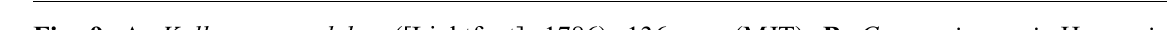
Fig. 9. A . Kalloconus pulcher ([Lightfoot], 1786), 136 mm (MJT). B . Conus siamensis Hwass in Bruguière, 1792, lectotype, 102 mm (MHNG-MOLL-52702). C . Kalloconus marimaris Tenorio, Abalde & Zardoya, 2018, holotype, 38.6 mm (MNCN 15.05/79664). D . Kalloconus marimaris , paratype, 36.6 mm (MNCN 15.05/79689). E . Conus pseudonivifer Monteiro, Tenorio & Poppe, 2004, holotype, 47.4 mm (MNCN 15.05/46627). F . Conus trochulus Reeve, 1844, lectotype, 26 mm (NHMUK 196179/1). G . Conus atlanticoselvagem Afonso & Tenorio, 2004 (= trochulus ), holotype, 38.0 mm (MNCN 15.05/46580). H . Kalloconus trochulus f. stanchinensis Cossignani & Fiadeiro, 2019, 31.4 mm (MNCN 15.05/88794). I . Kalloconus venulatus (Hwass in Bruguière, 1792), 52.4 mm (MNCN 15.05/80419). J . Kalloconus venulatus f. josefiadeiroi Cossignani & Fiadeiro, 2019, 33.2 mm (MNCN 15.05/79907). Scale bars = 10